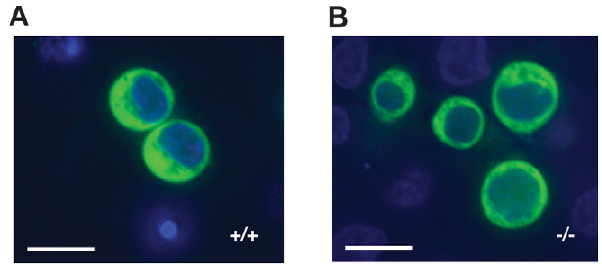
Figure 4. AID localization in CIB 2 / 2 DT40 cells. A . AID-EGFP localization in CIB1 + / + DT40. B . AID-EGFP localization in CIB1 2 / 2 DT40. Images were taken using a 40 6 objective and the scale bars indicate 10 m m.